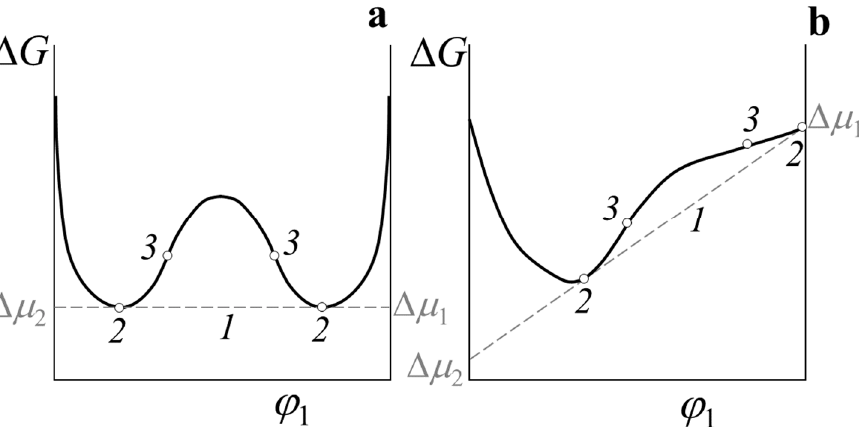
Figure 1. Method for simulation phase diagrams from fragments of binodal curves in the framework of the Flory–Huggins theory: ( a )—initial data on solubility, ( b )—temperature dependence of χ , ( c )—simulation of a generalized phase state diagram. Black dots—experimental data, solid thick lines—binodal curves, dashed line—spinodal curve. (See text for details).